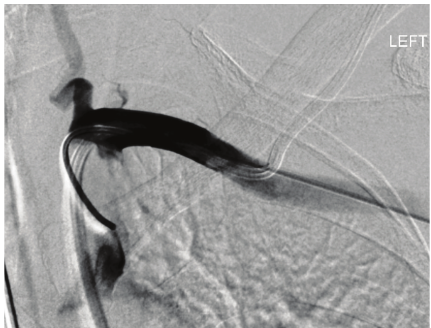
Figure 6: Catheter angiogram showing relation of catheter site to the left vertebral artery.